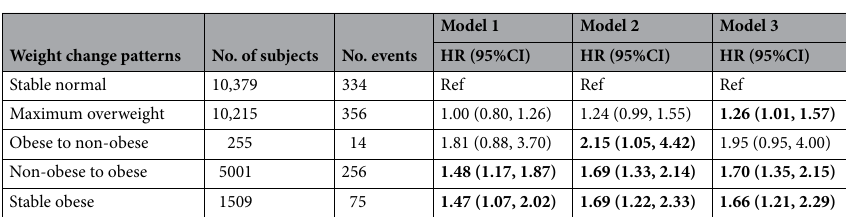
Table 2. Hazard ratios (HRs) and 95% confidence intervals (CIs) of incident asthma with weight change patterns across adulthood in NHANES 2001–2018 used the stable normal category as a reference. All estimates accounted for complex survey designs and the analyses used the sample weights, stratification and clustering suggested by the CDC. Significant results are in boldface type. Model 1: Non-adjusted model. Model 2: Adjusted for age at ten years before baseline, gender, race/ethnicity (Mexican American, non-Hispanic White, non-Hispanic Black, and other race). Model 3: Adjusted for age at ten years before baseline, gender, race/ ethnicity (Mexican American, non-Hispanic White, non-Hispanic Black, and other race), baseline education level (less than high school, high school or equivalent, college or above), baseline family income (family income-poverty ratio, 0–1.0, 1.1–3.0, > 3.0), baseline smoking status (ever smoke and never